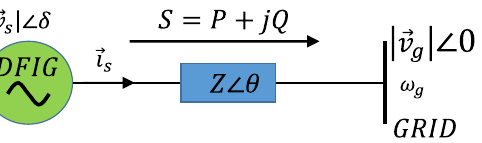
Figure 5. DFIG generator connected to the main grid trough line impedance.